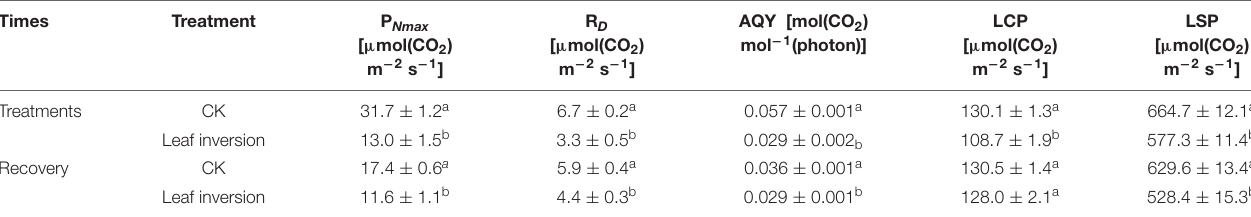
TABLE 2 | Photosynthetic light-response parameters of inverted leaves in 2021.